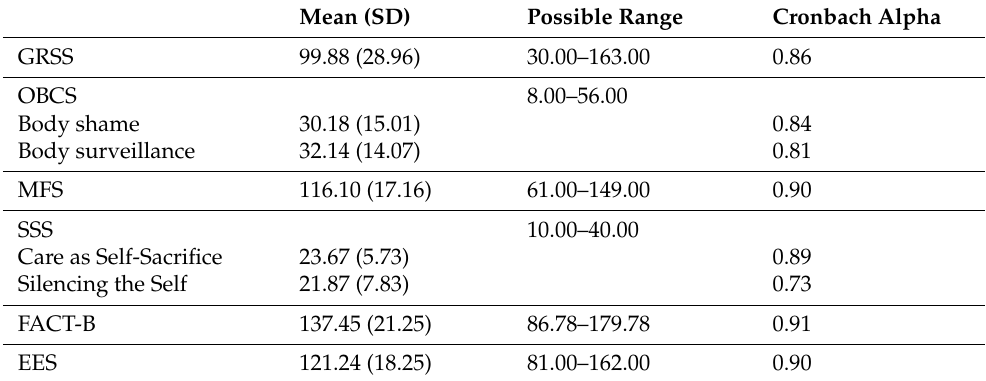
Table 2. Means, standard deviations, and Cronbach alphas of study variables ( N = 113). Mean (SD) Possible Range Cronbach Alpha 99.88